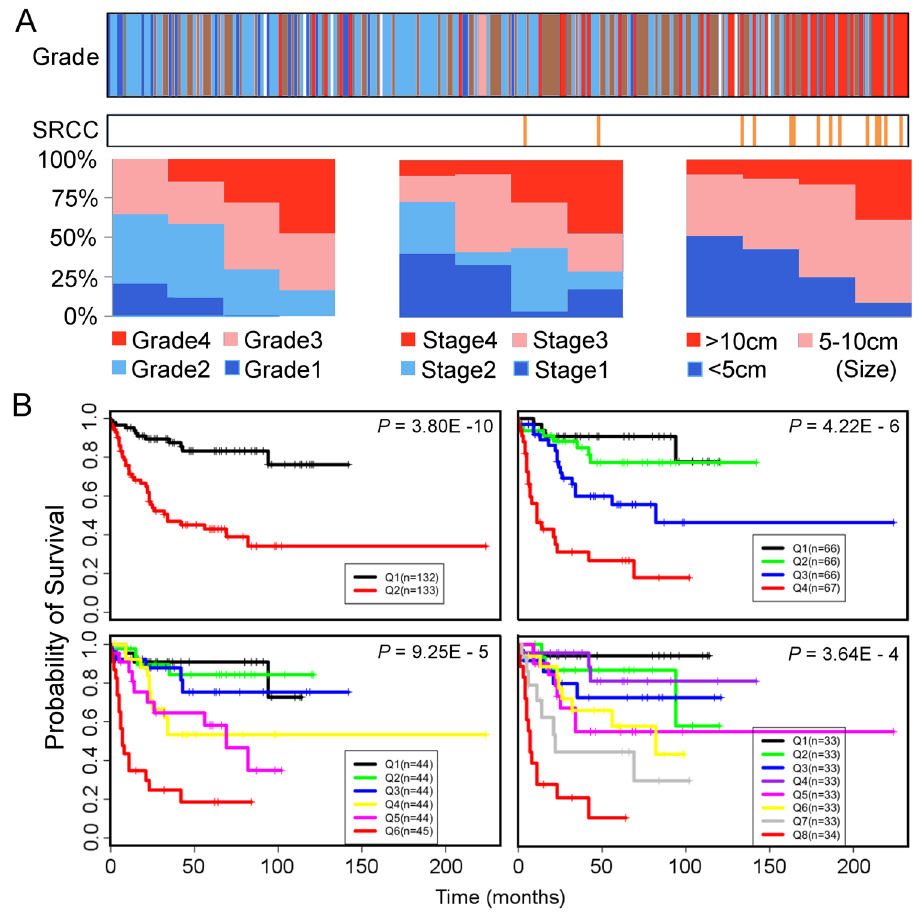
Figure 1. Validation of continuous linear enhanced assessment of ccRCC (CLEAR) by correlation and survival analysis. ( A ) Validation of CLEAR approach by correlation analysis with clinical variables. 265 ccRCC samples are ranked in ascending order based on CLEAR score. The top panel color bar represents the grade distribution profile of 265 ccRCC samples, expressed as colored vertical bars (white bars represent absent data). An association between high grade tumors and high CLEAR scores is observed (Fisher’s exact, p = 7.594e-07). A similar association between sarcomatoid RCC (SRCC) and high CLEAR scores is observed in the second horizontal bar (Mann-Whitney U test, p = 1.38e-06). To depict association with other key clinical variables, samples were evenly separated into 4 subgroups along the ranking queue with bar charts showing proportional breakdown of clinical variables. Correlation of tumor stage, tumor size with CLEAR score were observed (Fisher’s exact, p = 5.892e-05; Mann-Whitney U test, p = 1.10e-05, respectively). ( B ) Kaplan-Meier curves of cancer-specific survival for 265 ccRCC samples. We evenly grouped 265 ccRCC samples along the CLEAR scale into two (Q1 and Q2 groups), four (Q1–Q4 groups), six (Q1–Q6 groups) and eight (Q1–Q8 groups). In addition to inspection, Kaplan-Meier analysis was used to evaluate the association of these subgroups with survival, demonstrating a significant correlation with cancer-specific survival at all